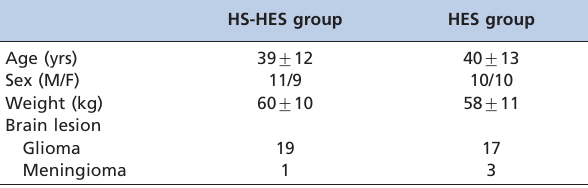
Table 1 - Demographic data for the patients treated with HS-HES (n= 20) or HES (n = 20).